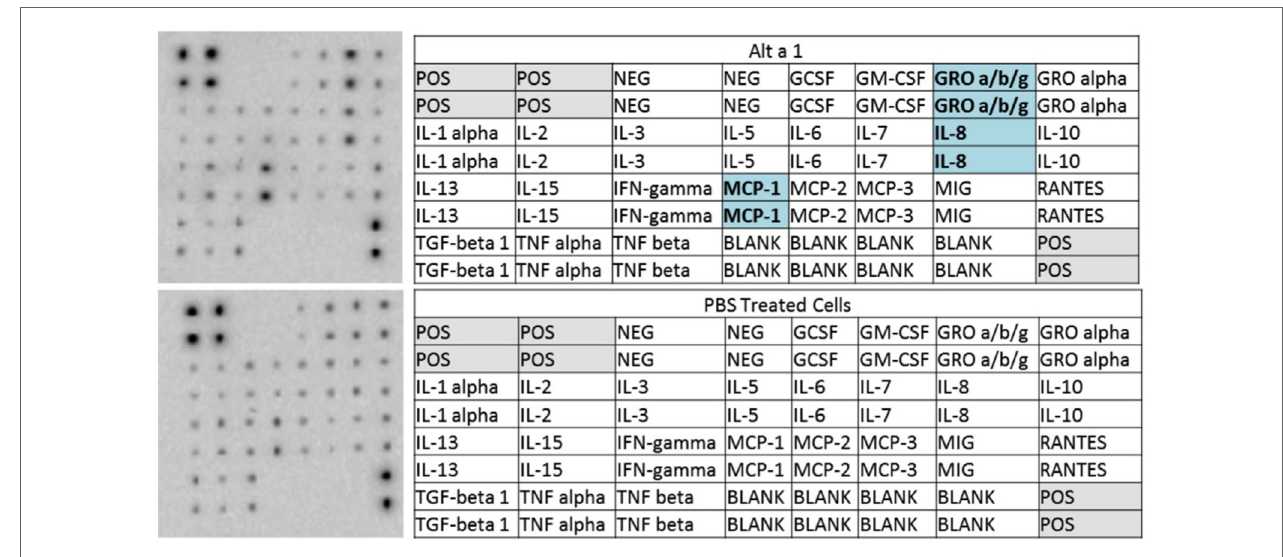
FigUre 1 | Cytokine profiling of rAlt a 1 treated BEAS-2B cells. 5.0 × 10 5 BEAS-2B cells were treated with 50 µg rAlt a 1 or 50 µL of endotoxin-free, sterile PBS (negative control). Cytokine array blots ( top left ) and corresponding maps of targets ( top right ) derived from cells treated with rAlt a 1, cytokine array blot ( bottom left ) and corresponding map of targets derived from cells treated with PBS ( bottom right ). Comparisons were made between the two blots and cytokines and chemokines highlighted in blue are those that were found to be qualitatively stronger in cells treated with rAlt a